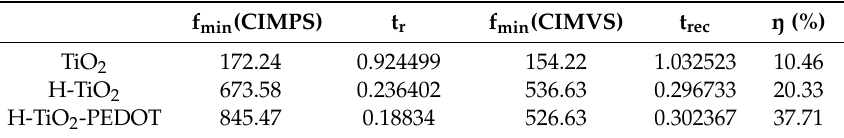
Table 1. The calculated data through CIMPS and CIMVS results.